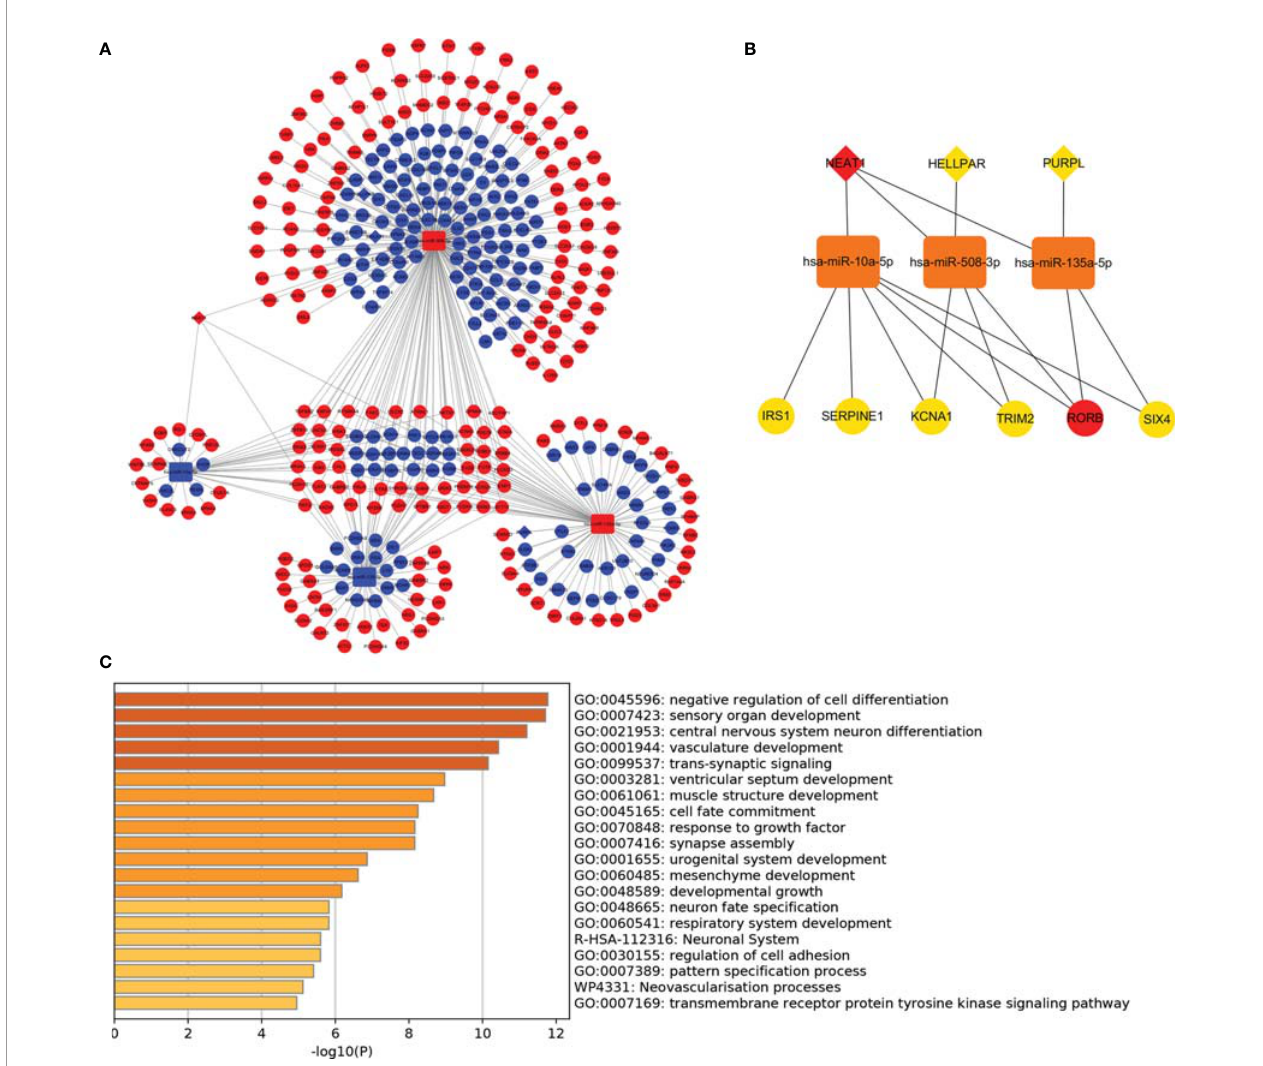
FIGURE 4 | Construction of ceRNA networks and functional annotation. (A) A triple regulatory network based on 4 lncRNAs, 4 miRNAs, and 387 mRNAs; (B) Hub genes network was constructed using plug-in “ cytoHubba ” ; (C) Functional enrichment analysis of